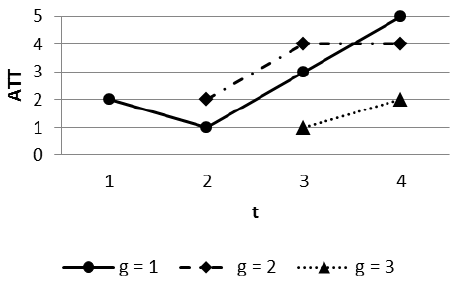
Figure 1. Hypothetical group-time ATTs: each line identifies a group of treated units that receive the treatment in a specific time period.